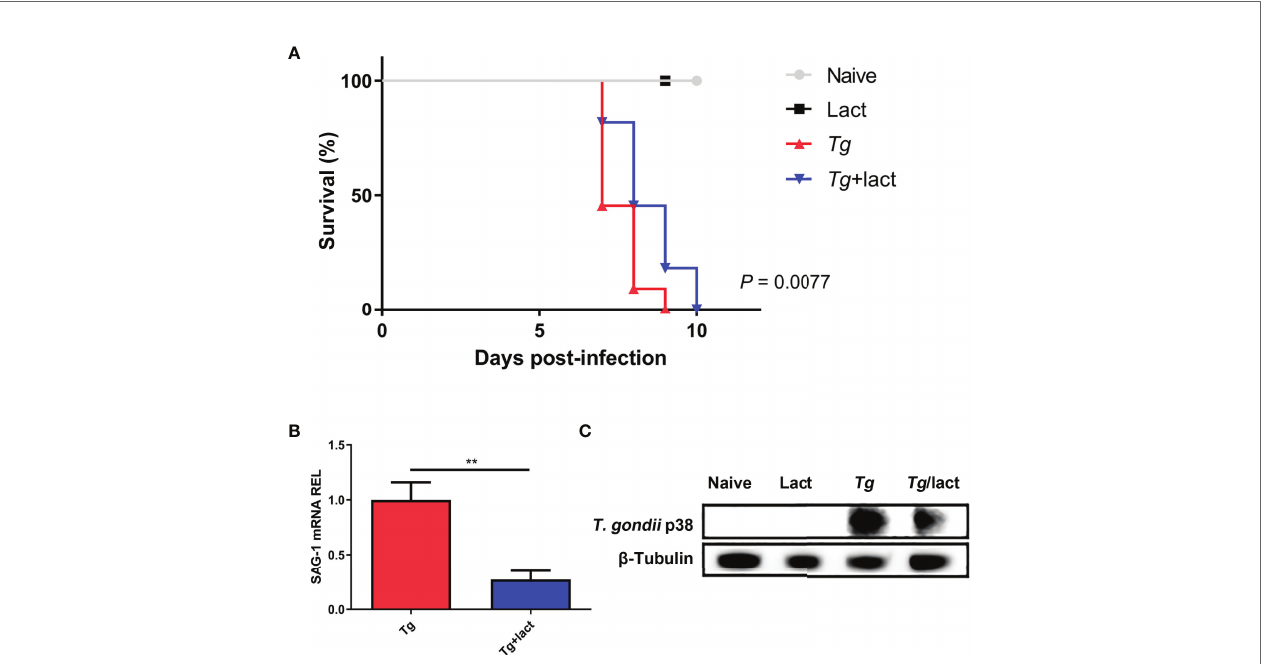
FIGURE 1 | Survival rate and parasite burden. (A) Survival rate. Tg- infected mice (n = 11) died between days 7 and 9 p.i., while Tg +lact mice (n = 11) died between days 7 and 10 p.i. (B) Parasite burden in the liver tissues was estimated based on SAG1 mRNA level measured by qRT-PCR. Values are means from triplicate measurements, and data are shown as − DD Ct values; two independent experiments were performed with four mice per group. ** P < 0.01. Y axis represents the mRNA relative expression level (REL) of different genes. (C) Parasite burden in the liver tissues was estimated based on the protein level of p38 from T. gondii detected by Western blot